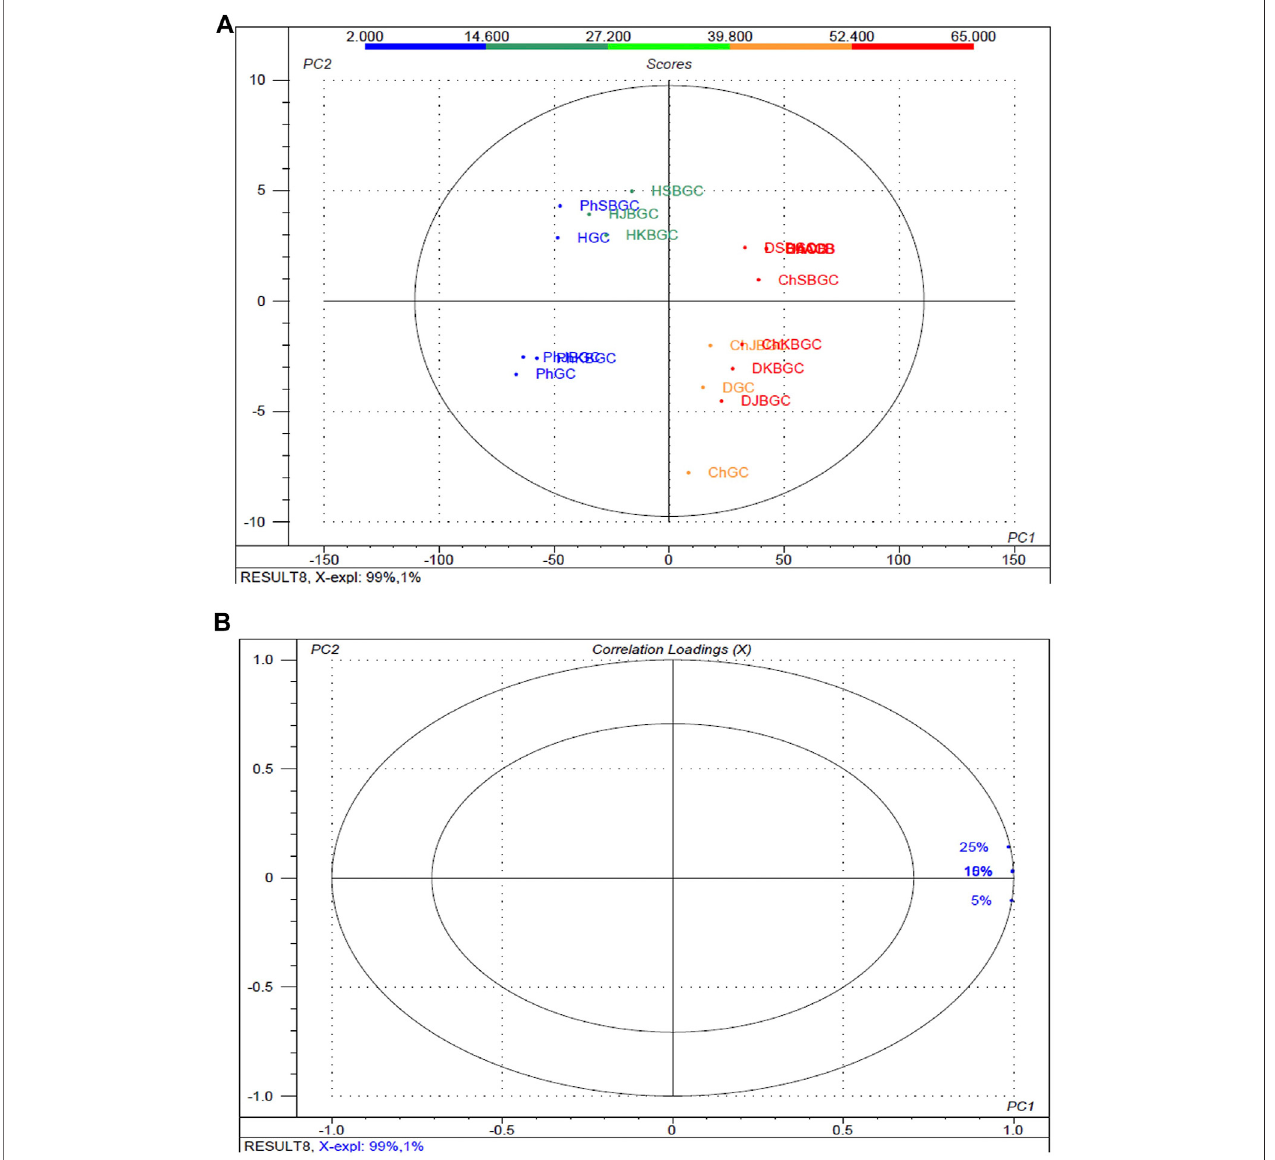
FIGURE 5 | Multivariate statistical analysis of codi fi ed different polarity Guduchi samples (Ph: phosphate buffer solution, D: dichloro methane, Ch: chloroform, and H: hexane) based on an unsupervized PCA model. (A) Unsupervized PCA score plot and (B) Loading plot of α -glucosidase activity of GC, JBGC, KBGC, SBGC formulations and various concentrations. The ellipse represents the Hotelling T 2 with 95% con fi dence.